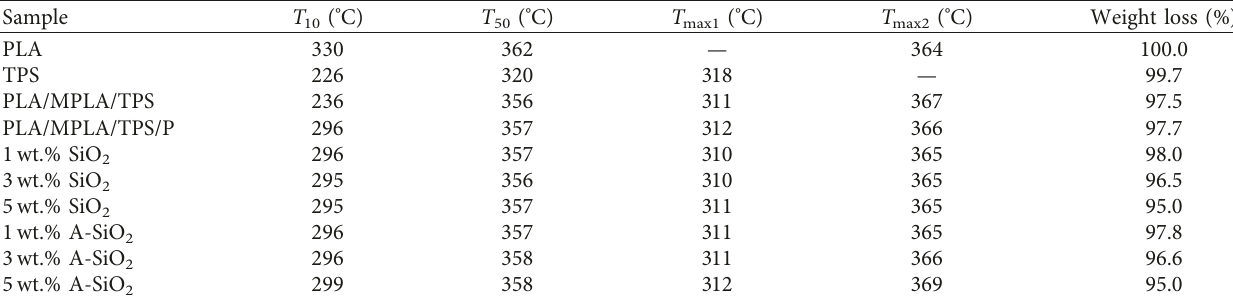
Table 4: TGA data of PLA, TPS, and various blends and composites in air.